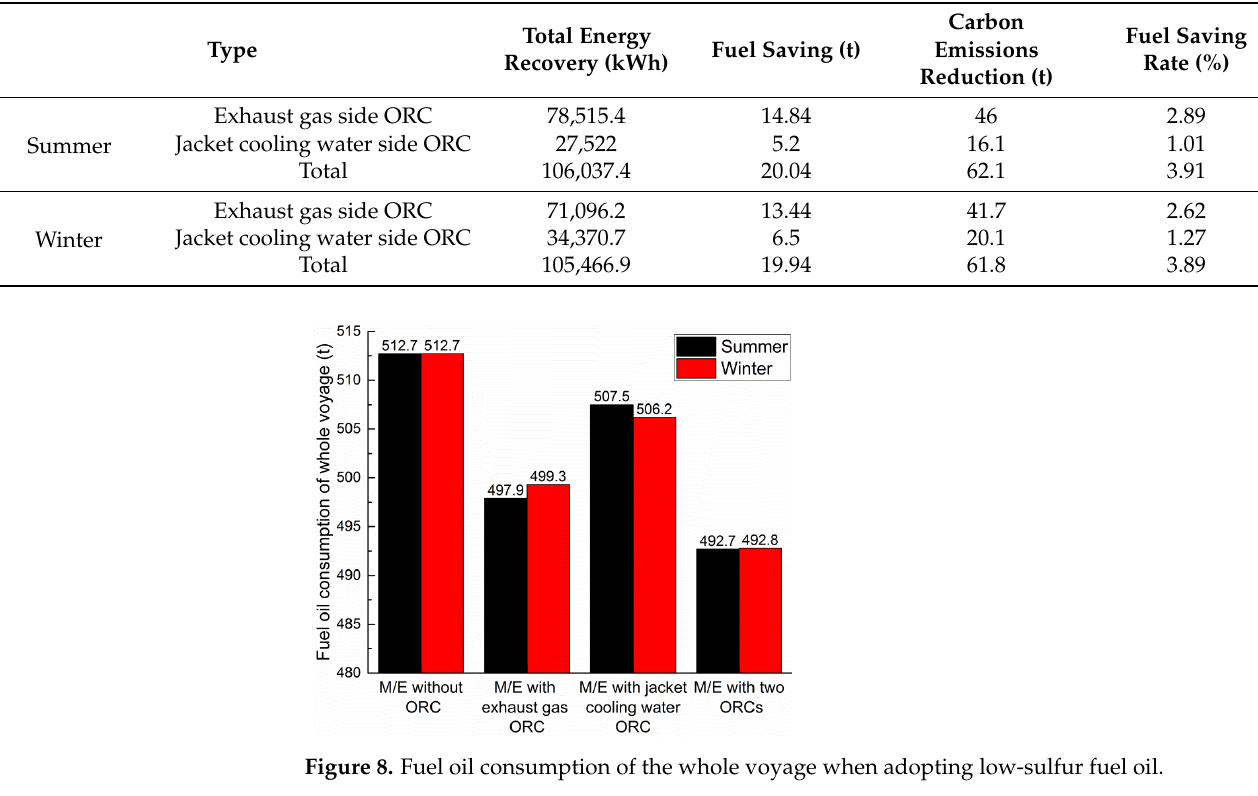
Table 13. Energy saving and fuel saving of the ship when adopting low-sulfur fuel oil.